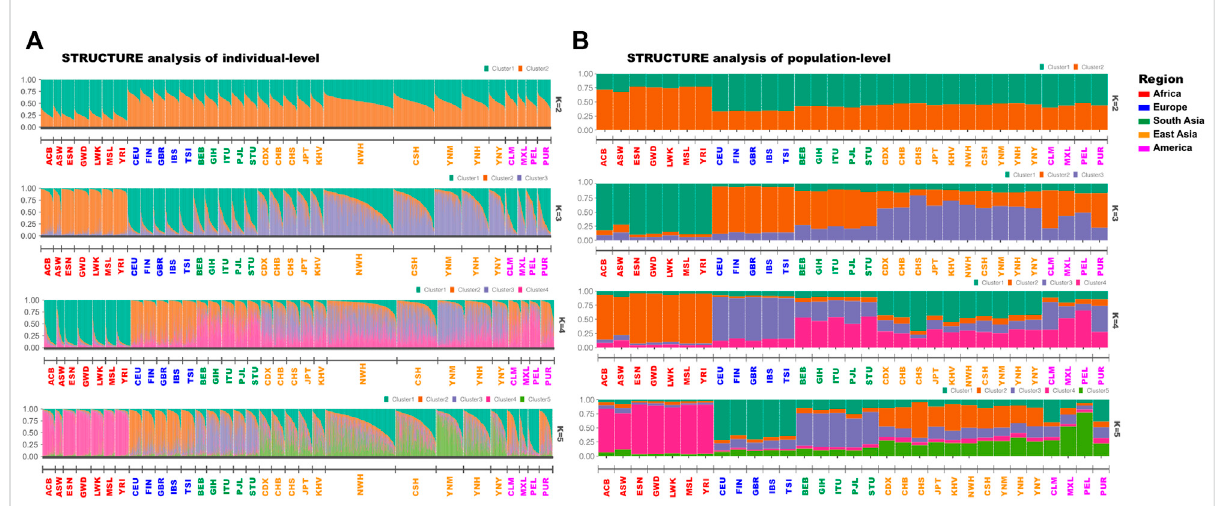
FIGURE 3 The results of STRUCTURE analyses of Yunnan Yi, Hani and Miao groups and 28 reference populations. (A) STRUCTURE results of individual- level were studied based on genotypes of 3890 individuals from fi ve continents. And the individuals among different populations were ordered according to the proportion of cluster one; (B) STRUCTURE results of population-level were analyzed based on 43 A-DIP genotype data of 31 populations from fi ve continents.